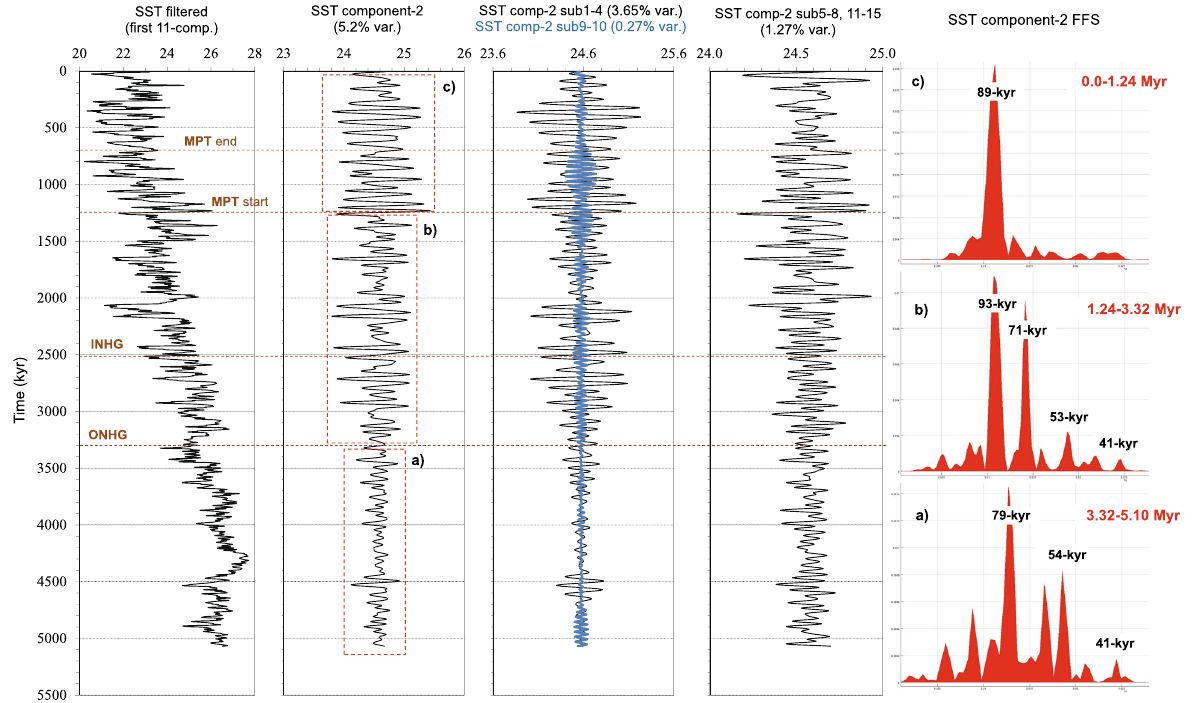
Fig. 7 Time-series panel of ODP Site 846 SST component-2 and its subcomponents and Fourier frequency spectrum of comp-2 for three time intervals a , b and c , highlighted by red-labeled boxes. The transition nature from a obliquity to c short eccentricity is less evident in this tropical SST site, but still present. The increasing amplitude of the short eccentricity is more clear in subcomp-1-4. The obliquity decrease after the MPT is still shown by subcomp-9-10. x -axis scale variable (°C). The y -axis scale of the frequency spectrum increases upwards. Time scale in